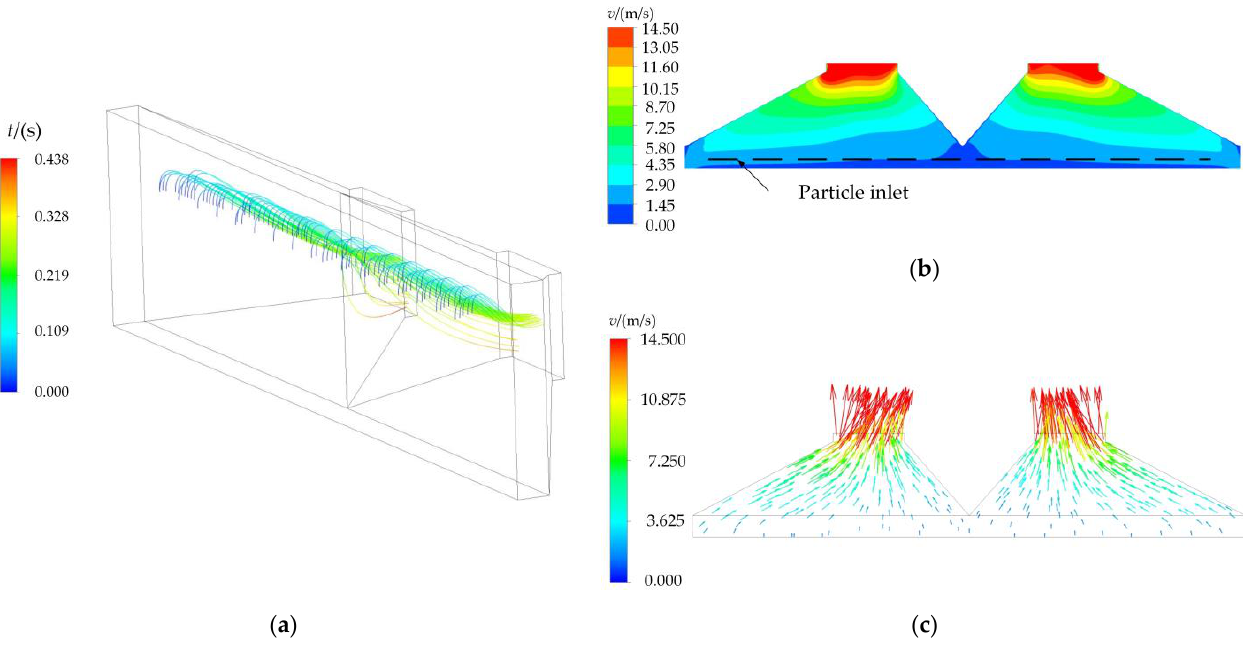
Figure 8. Particle trajectory and airflow velocity distribution (outlet velocity is 14.5 m/s). ( a ) Particle trajectory; ( b ) speed contour; ( c ) velocity